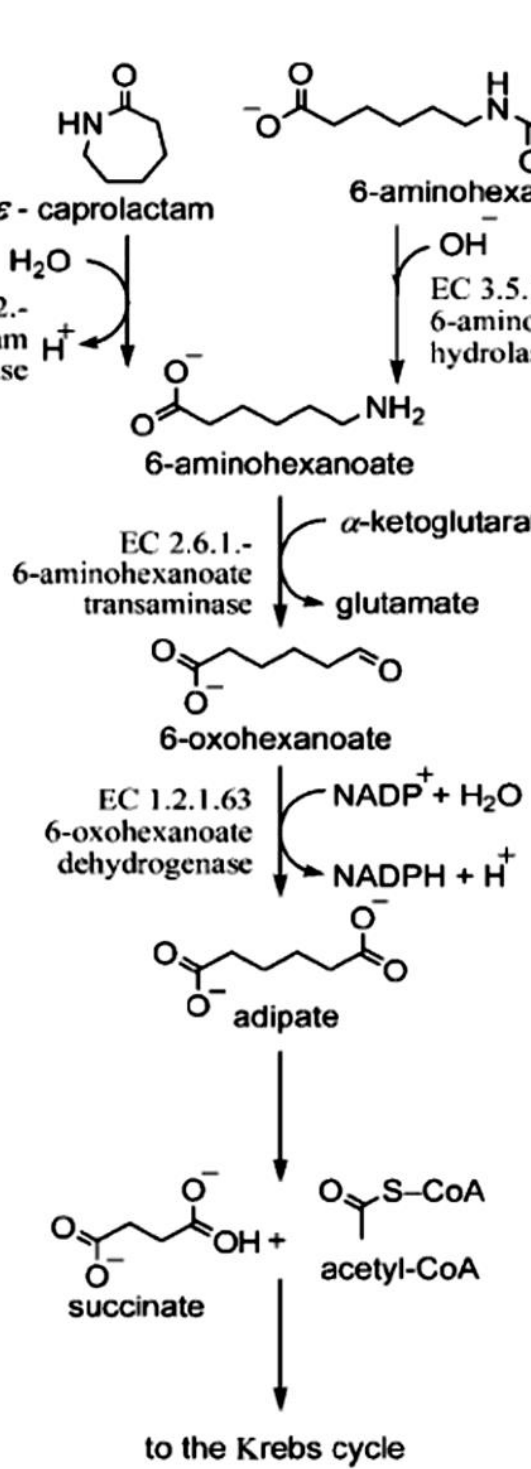
Figure 4. Scheme for the biodegradation of caprolactam and linear nylon oligomers (as exemplified by the dimer).